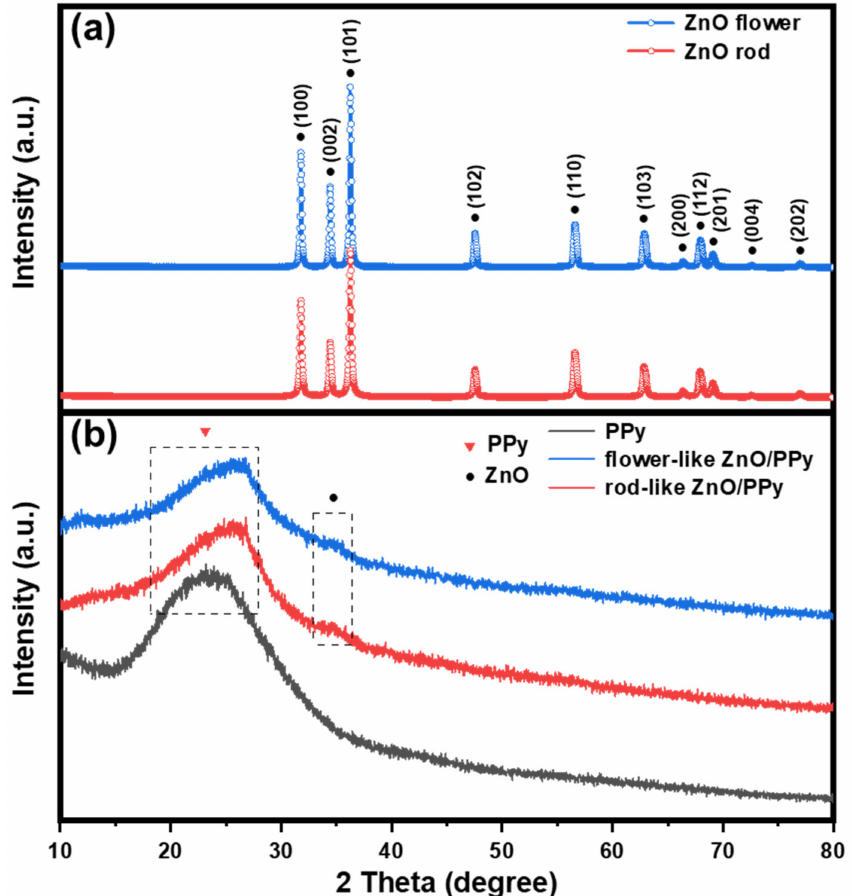
Figure 4. XRD patterns of ( a ) ZnO flower and ZnO rod; ( b ) PPy, flower-like ZnO/PPy, and rod-like ZnO/PPy